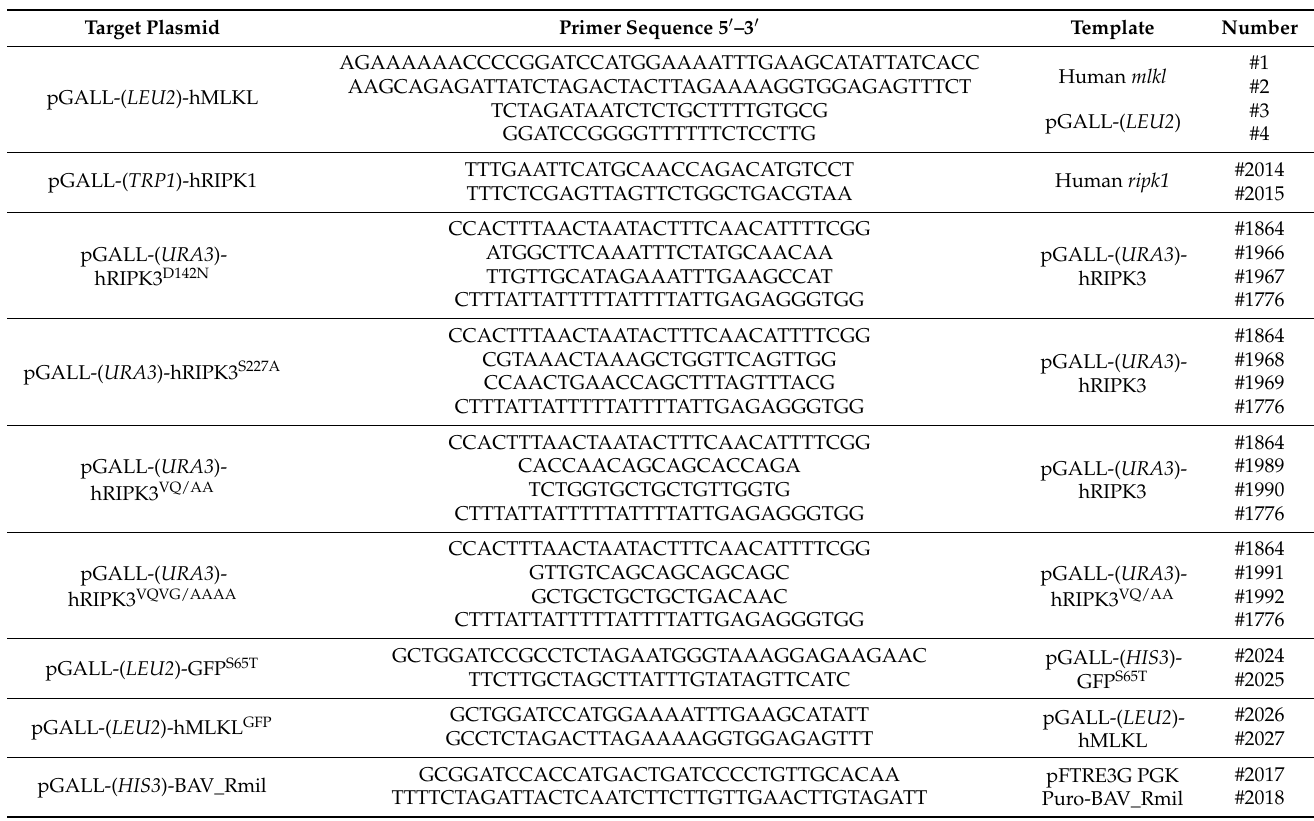
Table 1. Primers used to generate plasmids via